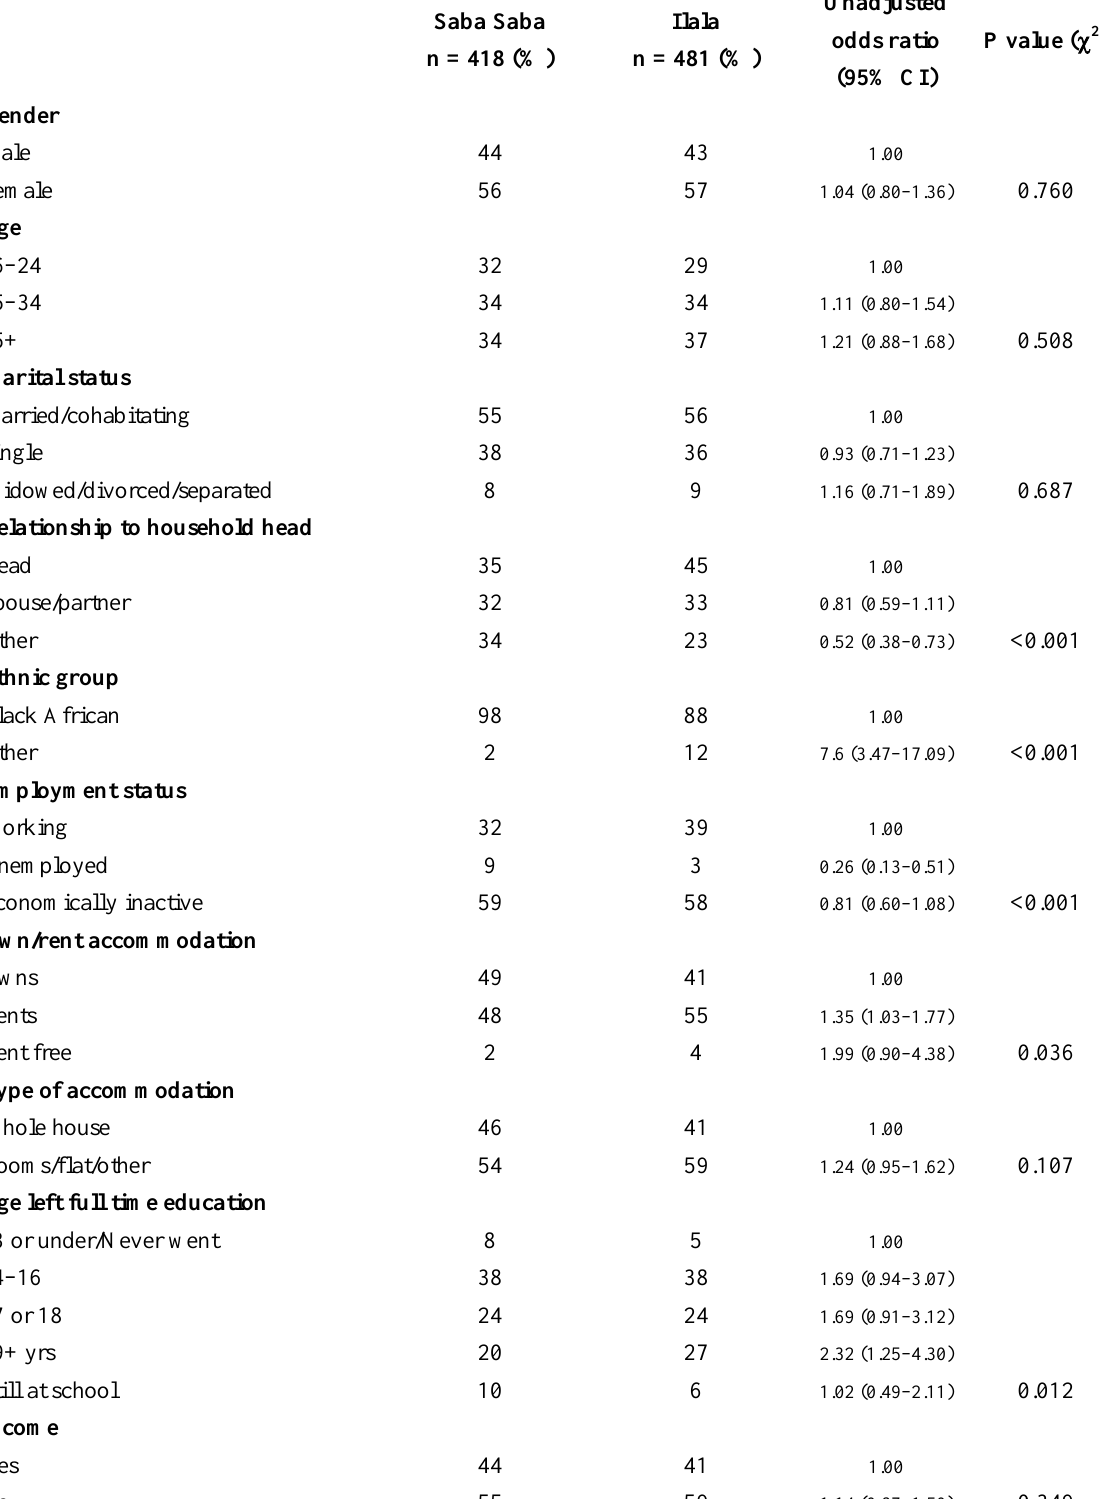
Table 1. Demographic & socio-economic factors, social support and life events by area.